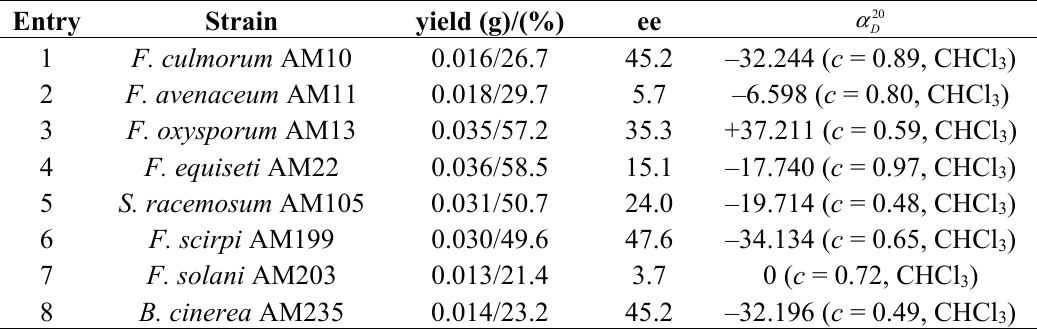
Table 4. Data on hydroxylactone 7a obtained during preparative biotransformations of lactone 5a .